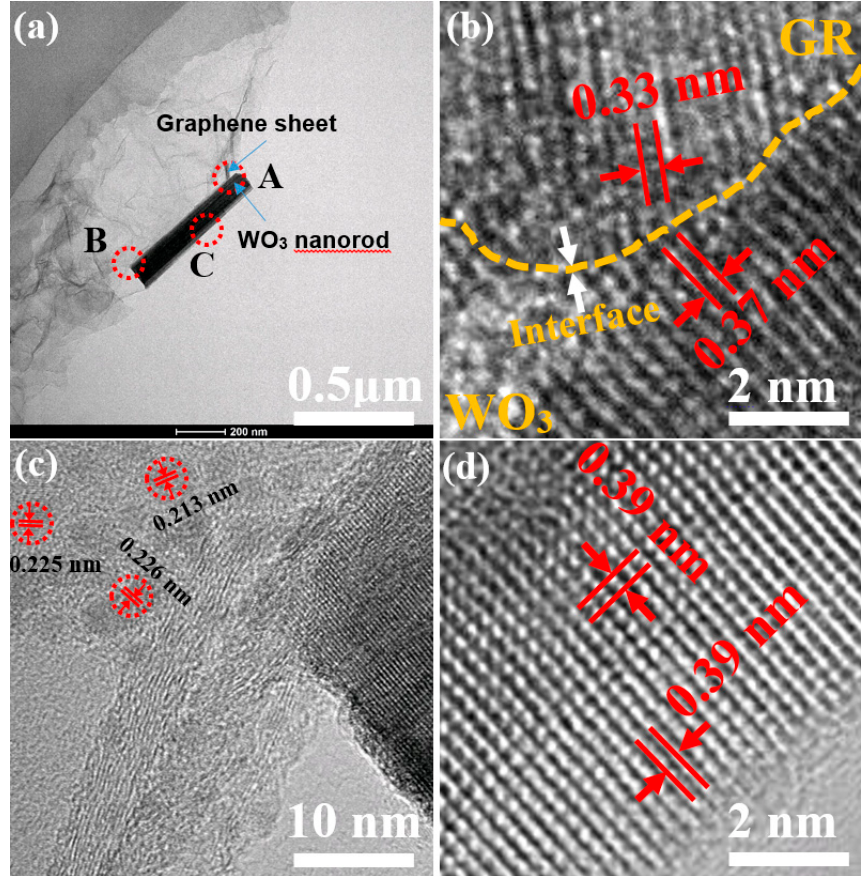
Figure 7. ( a ) Bright-field TEM images showing the WO 3 nanorod on the graphene sheet in the WO 3 /GR-0.1 nanocomposite; HRTEM images of regions: ( b ) A; and ( c ) B showing the GR/WO 3 interface; and ( d ) HRTEM image inside WO 3 (region C in ( a )).